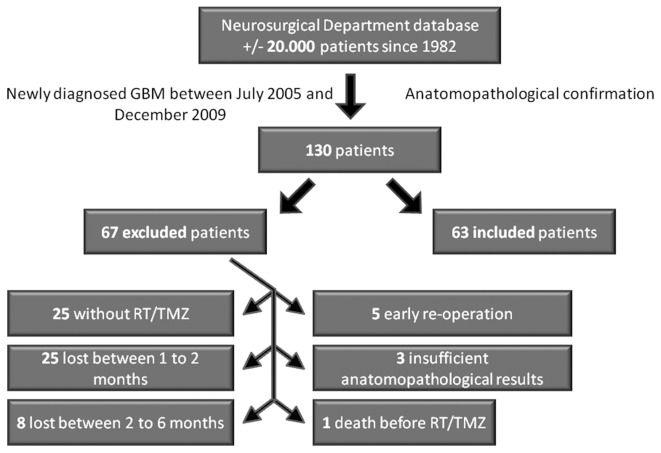
Patient selection.